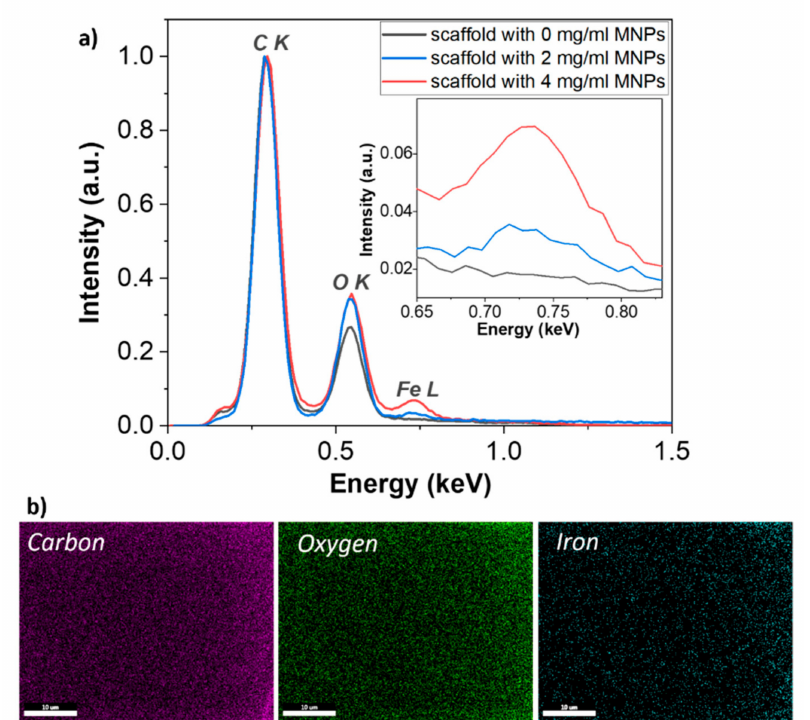
Figure 4. ( a ) Energy-Dispersive X-ray Spectroscopy (EDS) spectra of polymerized Ormocore / MNPs composite with MNPs concentrations of 0, 2 and 4 mg / mL; ( b ) EDS mapping of oxygen, carbon and iron from the polymerized Ormocore / MNPs composite with 4 mg / mL MNPs